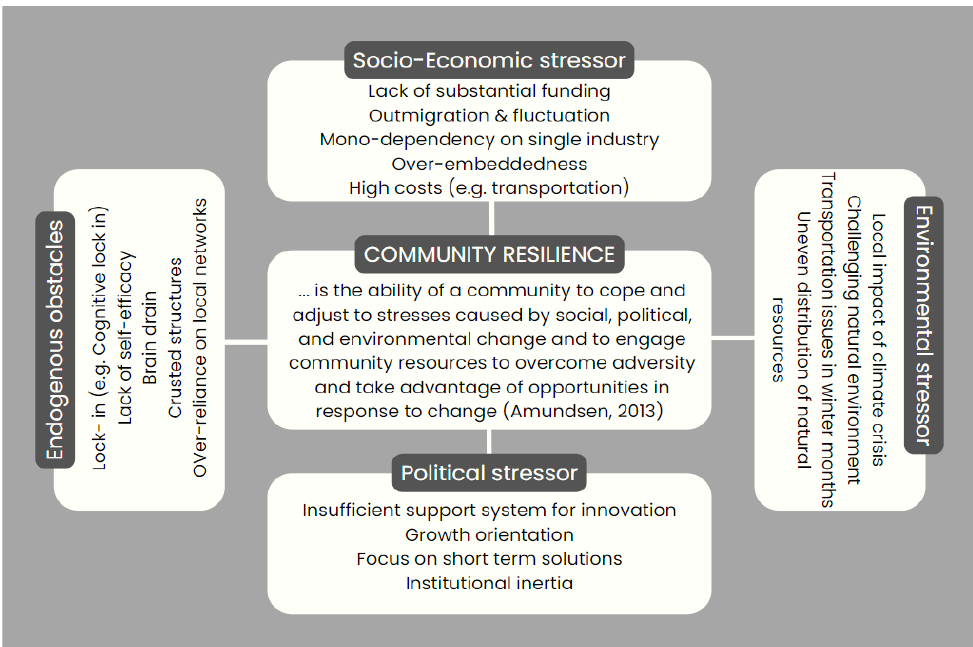
Fig. 1. Community Resilience in the context of different external stressors and local obstacles in